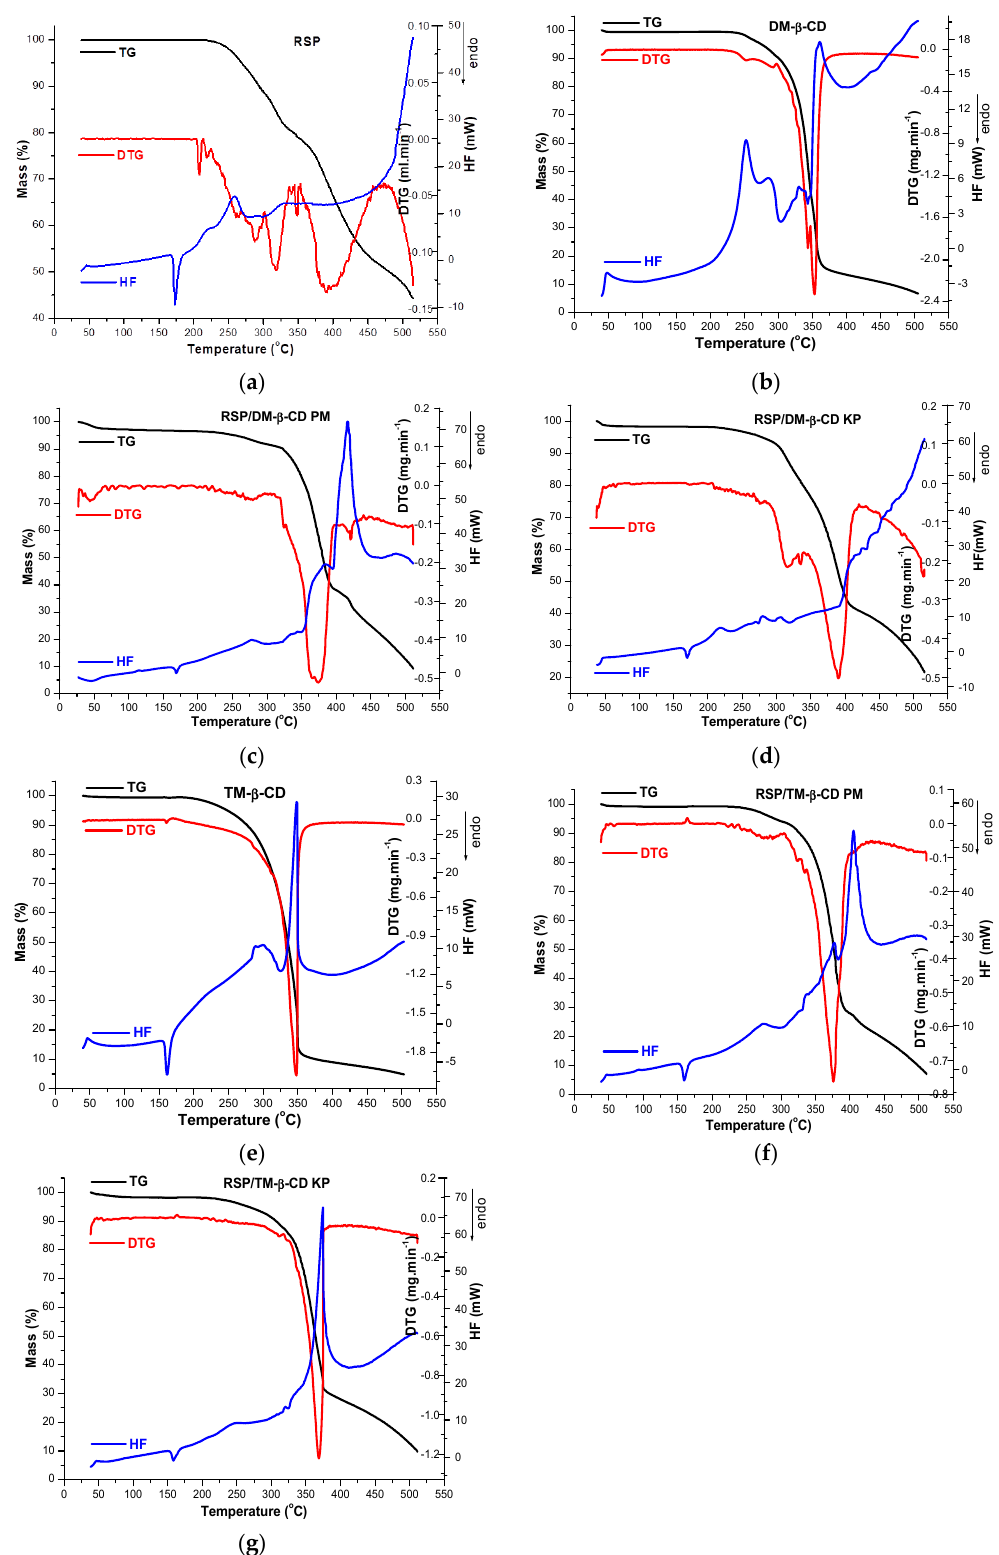
Figure 6. Thermoanalytical curves (thermogravimetry (TG) / derivative thermogravimetry (DTG) / heat flow (HF)) of: RSP ( a ); DM- β -CD ( b ); RSP / DM- β -CD physical mixture (PM) ( c ); RSP / DM- β -CD kneaded products (KP) ( d ); TM- β -CD ( e ); RSP / TM- β -CD PM ( f ) and RSP / TM- β -CD KP ( g ) in air atmosphere, 40–500 ◦ C temperature range and heating rate of 10 ◦ C · min − 1